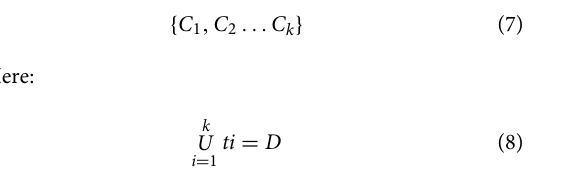
FIGURE6 Score analysis decision tree.